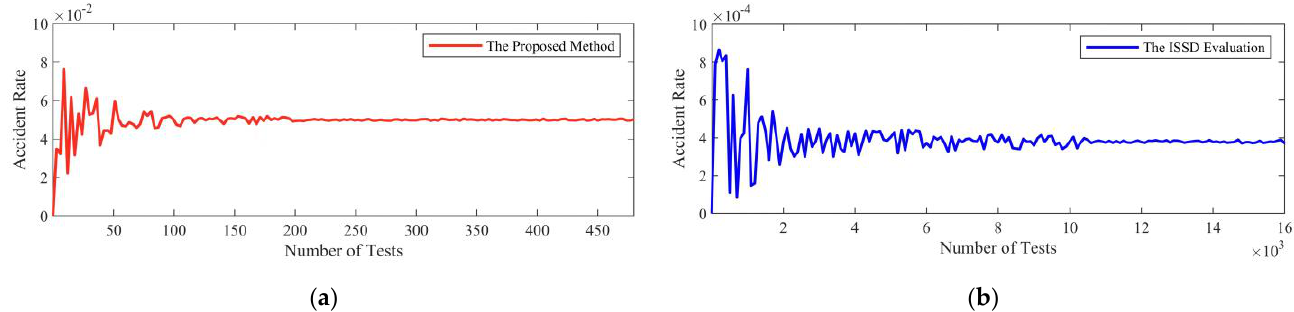
Figure 15. The accident rate of simulation tests of the LD-Scenario. ( a ) The red line denotes the accident rate by the proposed method. ( b ) The blue line denotes the accident rate by the ISSD evaluation method.